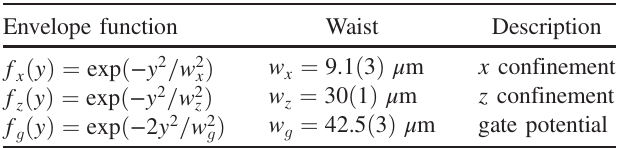
TABLE I. Envelope functions determining the effective quasi- one-dimensional potentials.